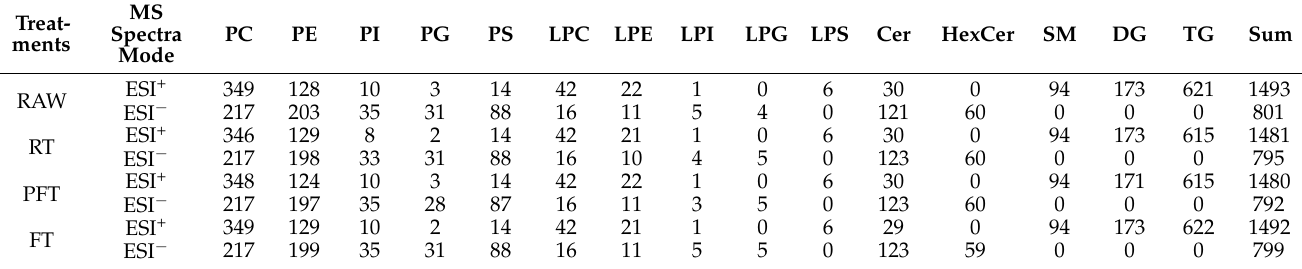
Table 2. Comparisons of total lipid molecular numbers of different lipid species of L. vannamei after low-temperature storage. MS Treat- ments